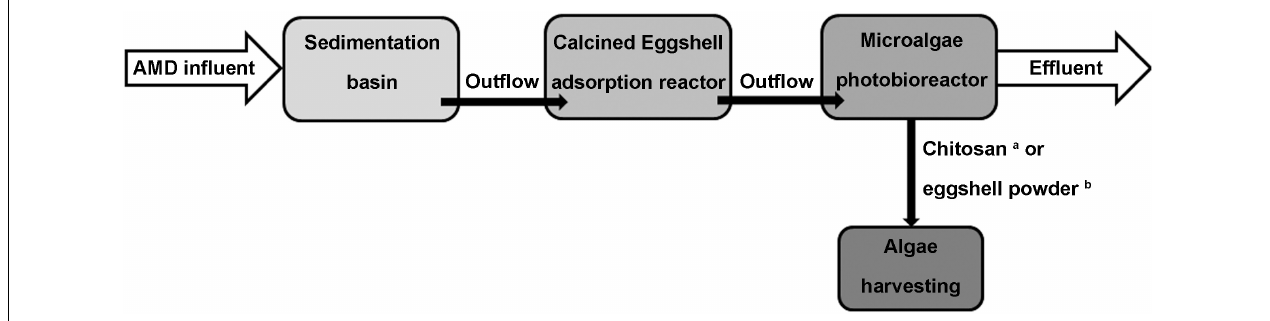
FIGURE 8 | Schematic presentation showing the utilization of ES for the production of biomass. a: Acid Mine Drainage treatment using ES and microalgae hybrid system (KR101605096B), and b: harvesting microalgal biomass